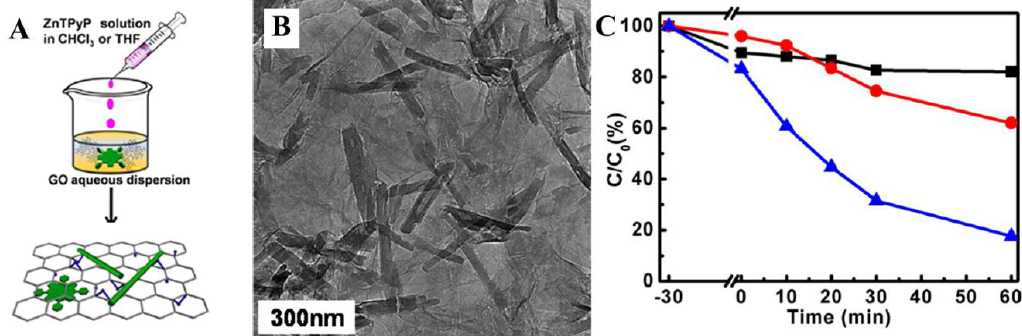
Figure 7. ( A ) Schematic illustration for the assembly of ZnTPyP 1D nanostructures via graphene oxide (GO)-based surfactant-assisted self-assembly (SAS); ( B ) TEM image of ZnTPyP/GO complexes; ( C ) photocatalytic activity of the original GO nanosheets (black ■ ▪), 1D ZnTPyP nano-assemblies formulated via the CTAB-assisted (red ●) and GO-assisted (blue ▲ ) SAS, for the photodegradation of RhB under visible-light irradiation. Reprinted with permission from [53]. Copyright 2013, American Chemical Society.